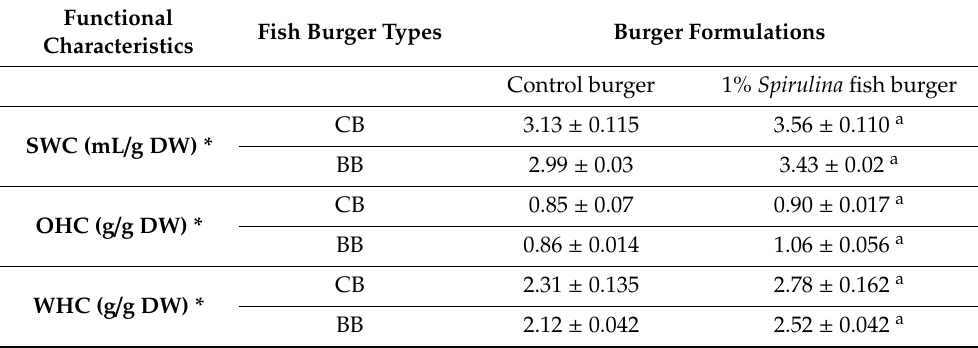
Table 4. Functional parameters of control and Spirulina -fortified fish